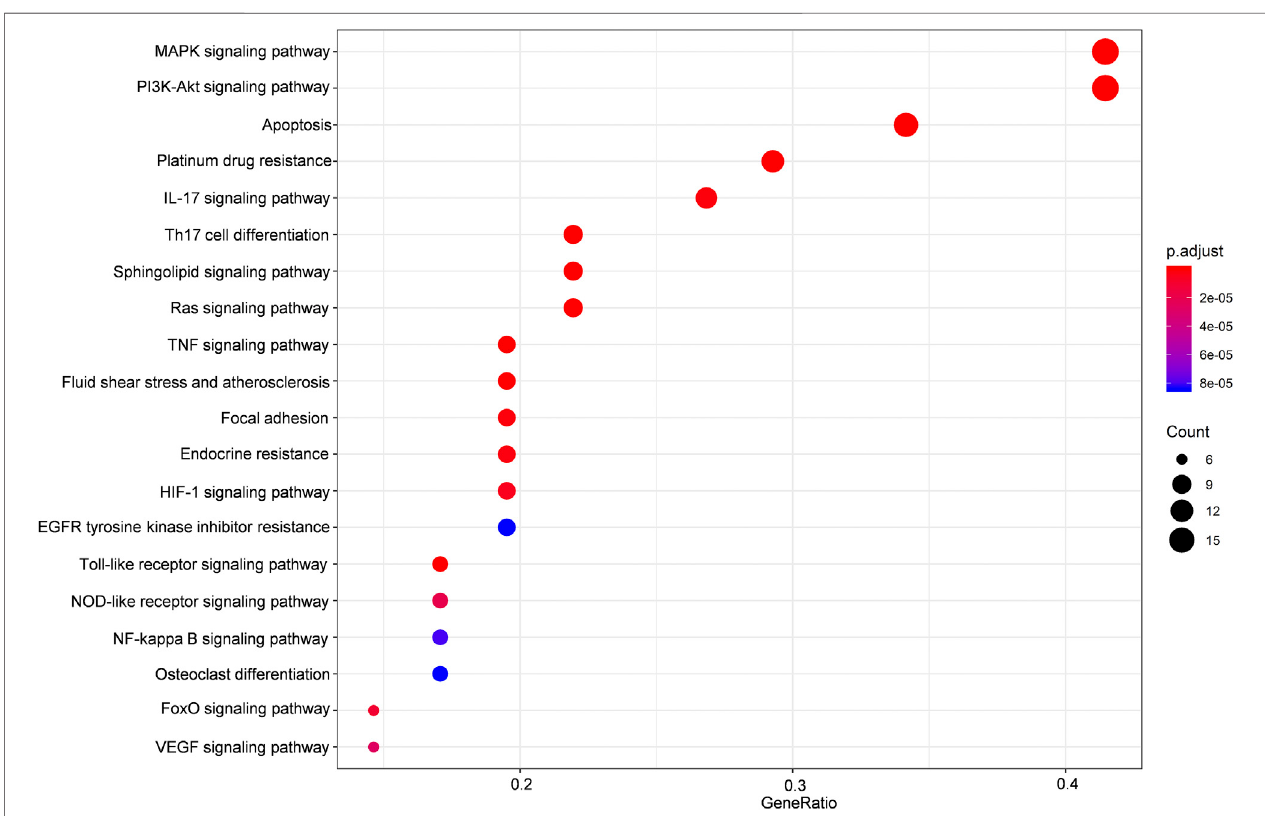
FIGURE 3 | KEGG enrichment analysis of the predicted targets of HLJDT for MI treatment. Dot plot showing the top 20 KEGG pathways: the size of the dots corresponds to the number of genes annotated in the entry, and the color of the dots corresponds to the corrected P-value.